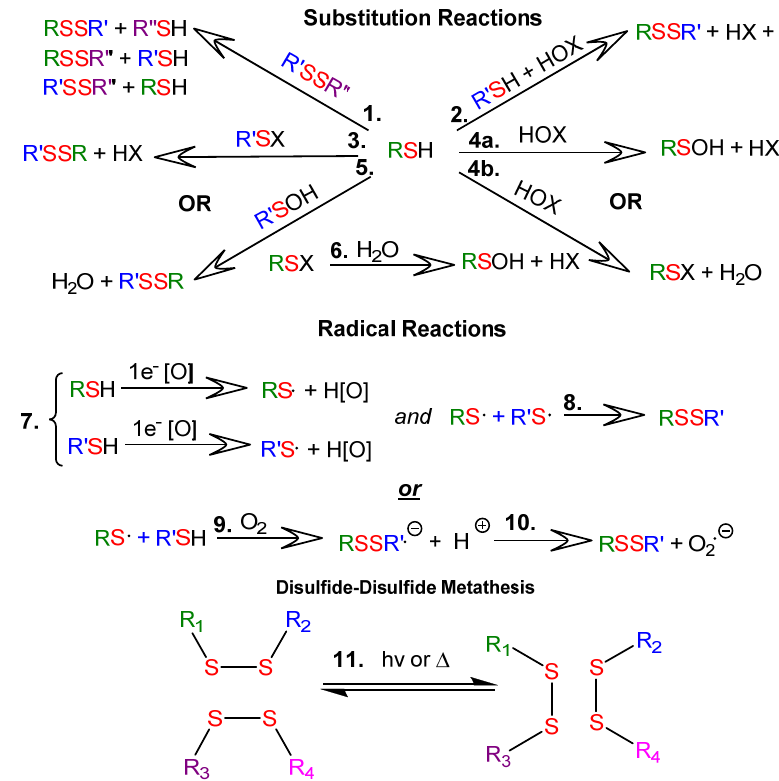
Figure 1 . Reactions of thiols (RSH) and disulfides (RSSR): 1.1 S N 2-mediated thiol-disulfide exchange; 1.2 – 1.6. Thiol oxidation with two-electron oxidants, where RSX is a sulfenyl halide, RSOH is a sulfenic acid, HOX is a halohydrin, and HOx is the reduced oxidizing agent; 1.7 – 1.10 Thiol oxidation with one-electron oxidizing agents; 1.11 disulfide-disulfide metathesis.